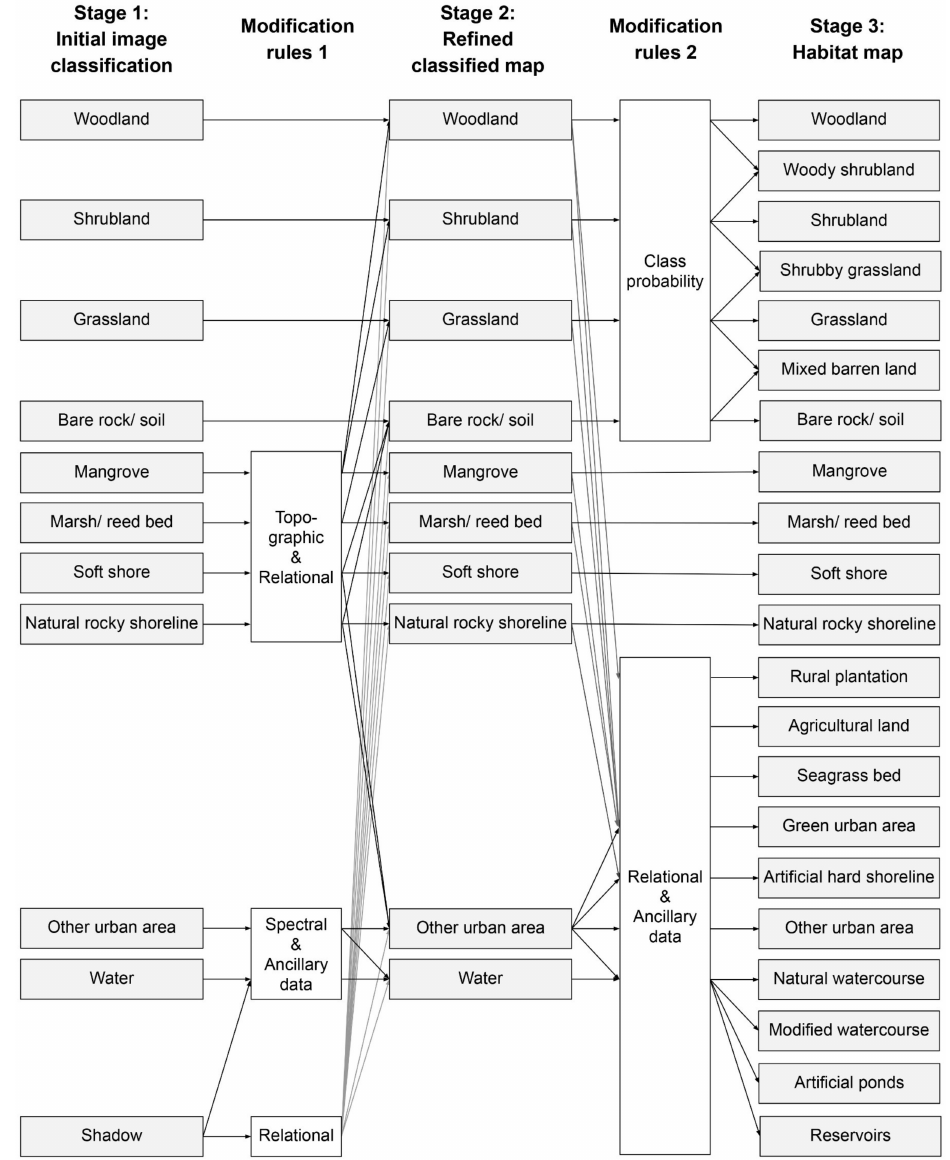
Figure 3. The three-stage classification framework adopted in this